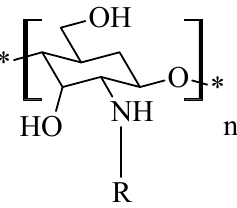
Figure 5. Hydroxypropyl derivatives of chitosan.